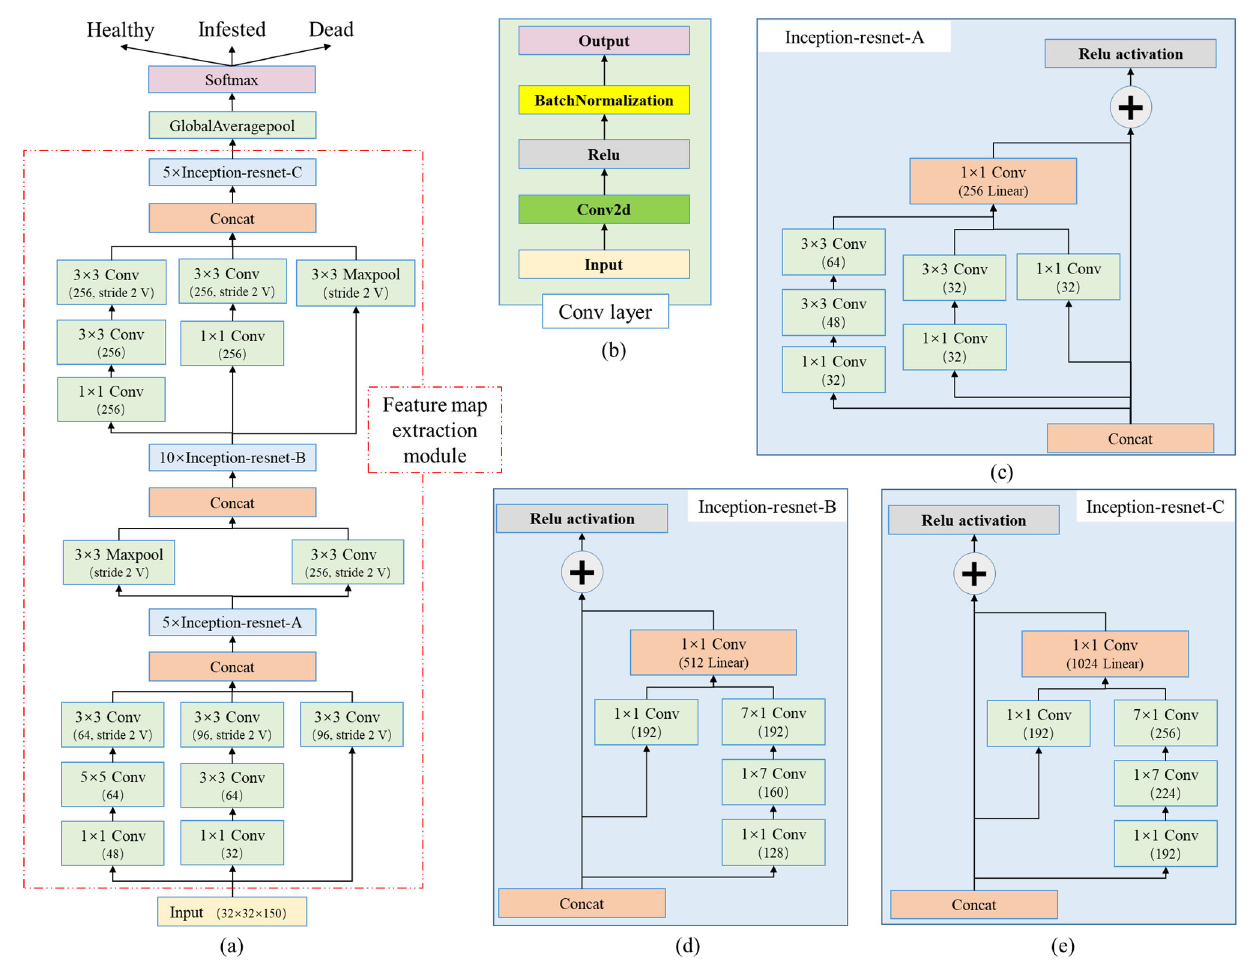
Figure 6. Schematics of the CNN model. ( a ) The overall architecture of the model; ( b ) convolution layer architecture containing a 2D convolution, Relu activation function and BatchNormalization layer; ( c – e ) Inception-resnet